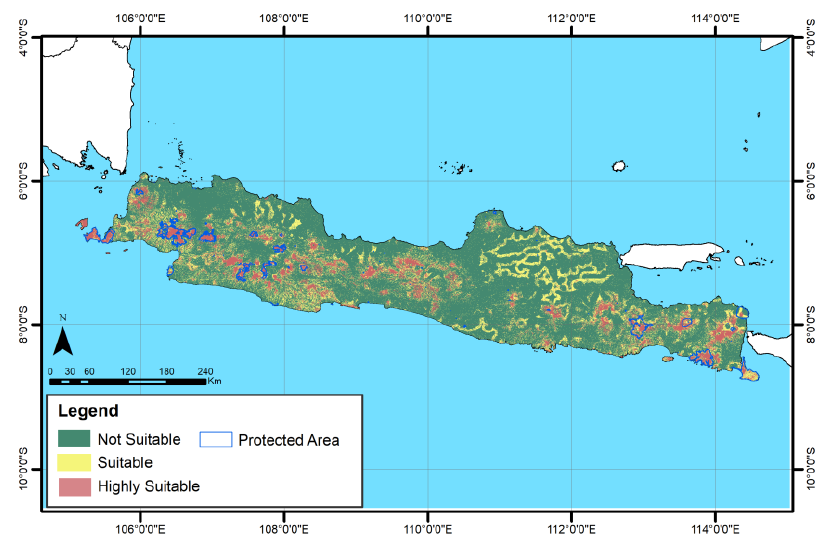
Figure 9. Map of highly suitable habitat for the Javan leopard in conservation areas in 2020.